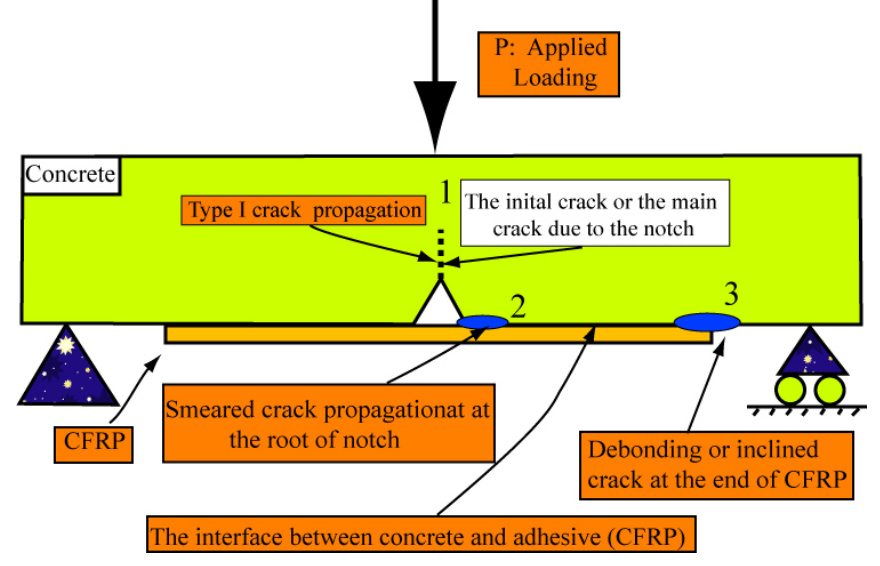
Figure 9. The critical stress regions for a CFRP-strengthened concrete